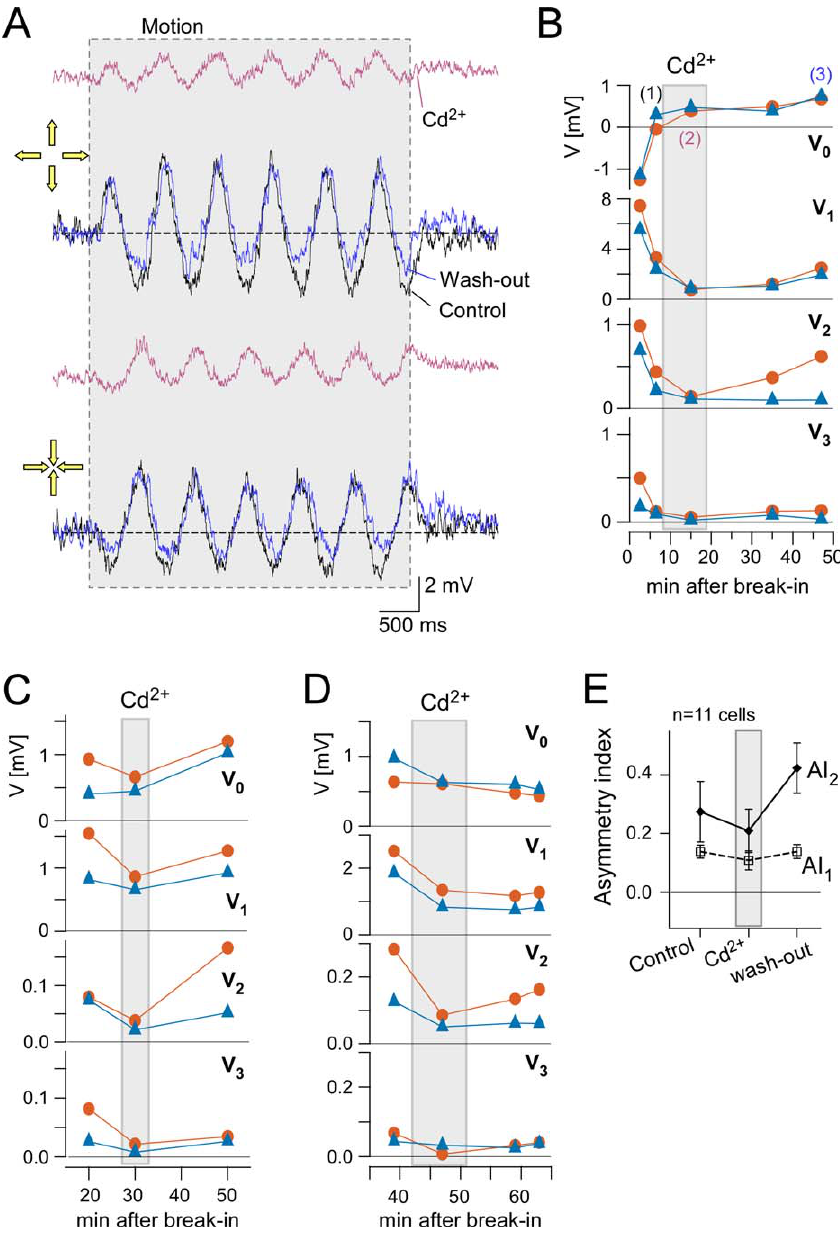
Figure 6. Effects of Cd 2 þ (A) Voltage responses to circular wave stimuli (3 Hz; 57% contrast; period: 192 l m) recorded before (control, V Rest ¼(cid:2) 63 mV; black), during ( V Rest ¼(cid:2) 52 mV; purple) and after (washout, V Rest ¼ (cid:2) 63 mV; blue) bath application of 10 l M Cd 2 þ . Traces (averages of three trials) are overlaid to facilitate comparison. Gray area indicates motion duration. (B–D) Amplitudes of DC ( V 0 ), fundamental ( V 1 ), and harmonics ( V 2 and V 3 ) plotted over time (in minutes after break-in; CF motion: orange circles; CP motion: blue triangles). Three different cells are shown ([B] shows the data from the cell in [A]; traces in [A] are at 6.5, 15, and 47 min after break-in). (E) AI s for V 1 (open squares) and V 2 (filled diamonds). For statistics, see Table 1.